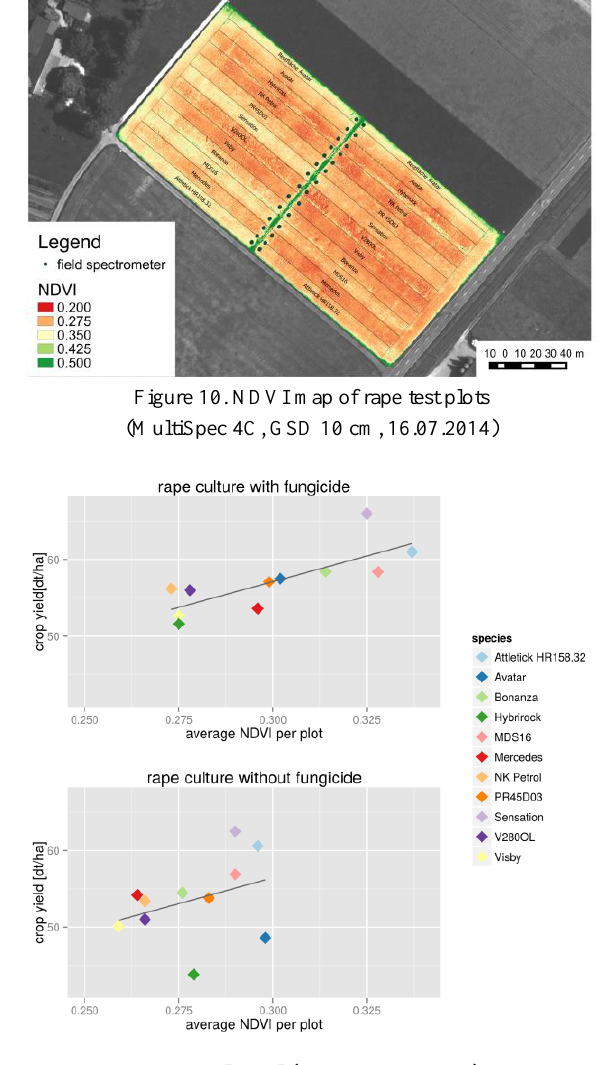
Figure 11. Crop yield [dt/ha] (equiv. to 100 kg/ha) in relation to the mean NDVI values per plot by species with fungicide treatment (top) and without treatment